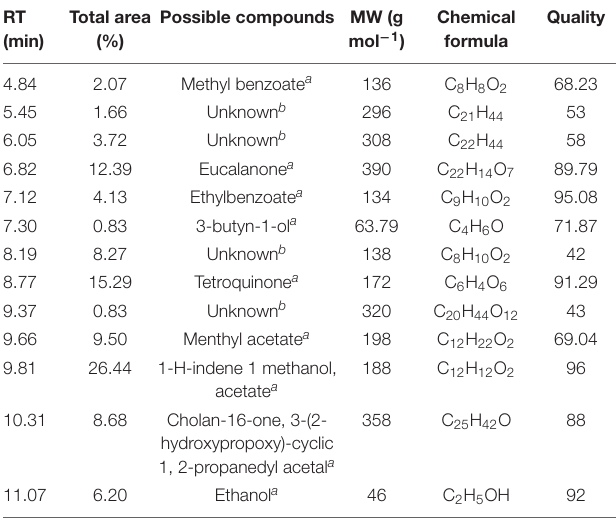
TABLE 6 | A list of bioactive compounds present on the Spot B of the TLC plate identified by GC-MS analysis. RT Total area Possible compounds MW (g (min) (%)